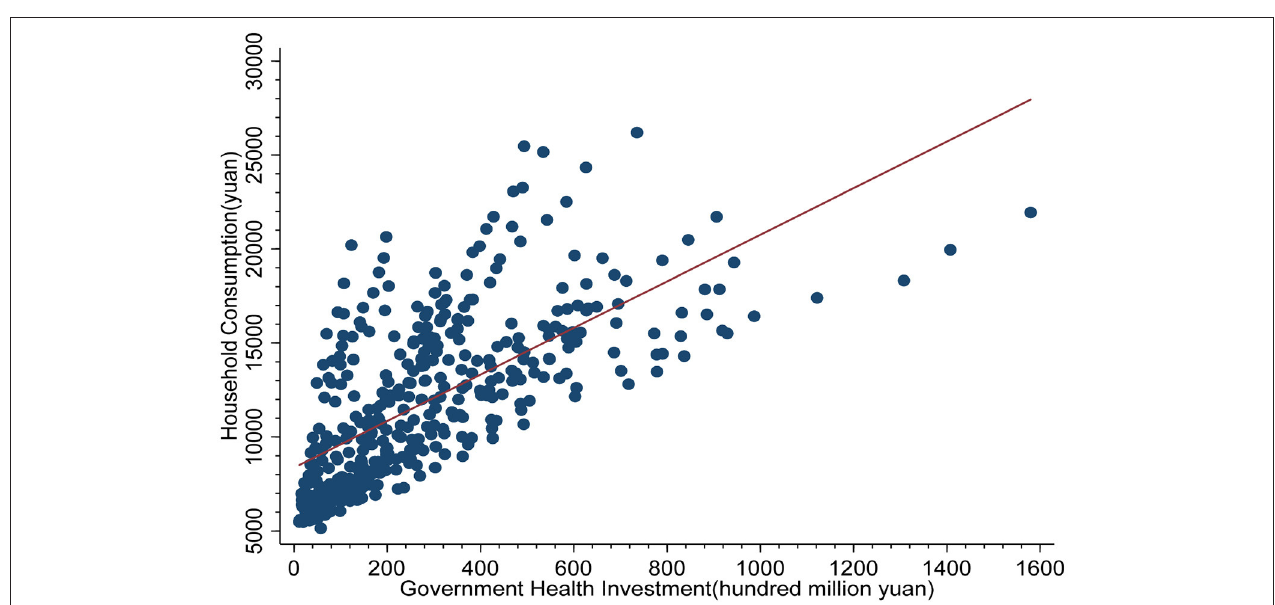
FIGURE 3 | Scatter plot of government health investment and household